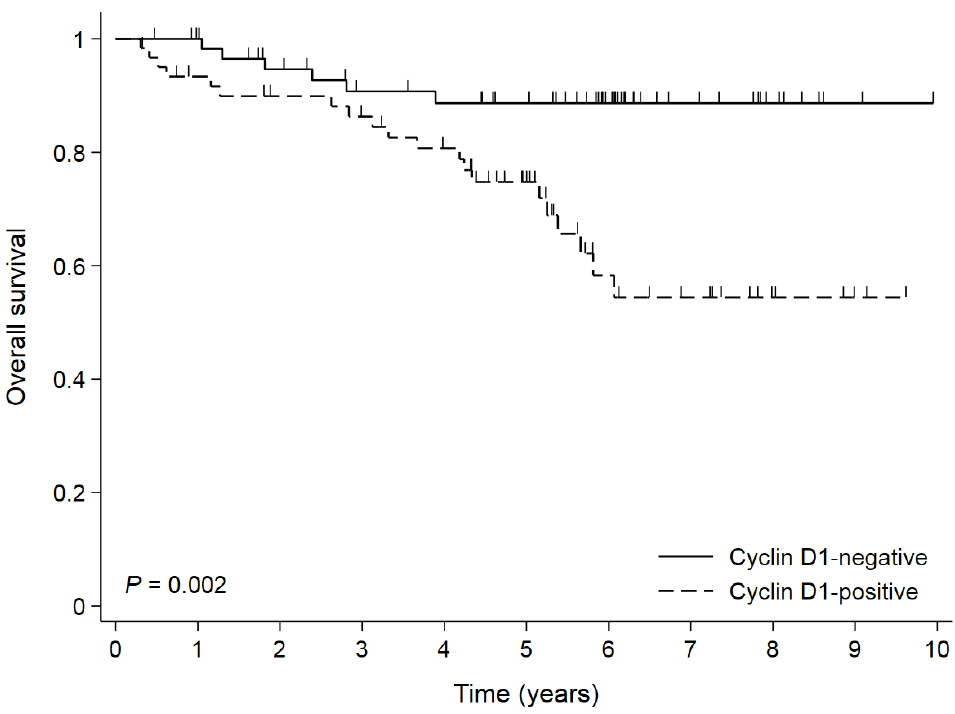
Figure 5. Overall survival by cyclin D1 positivity in propensity score-matched cohort.